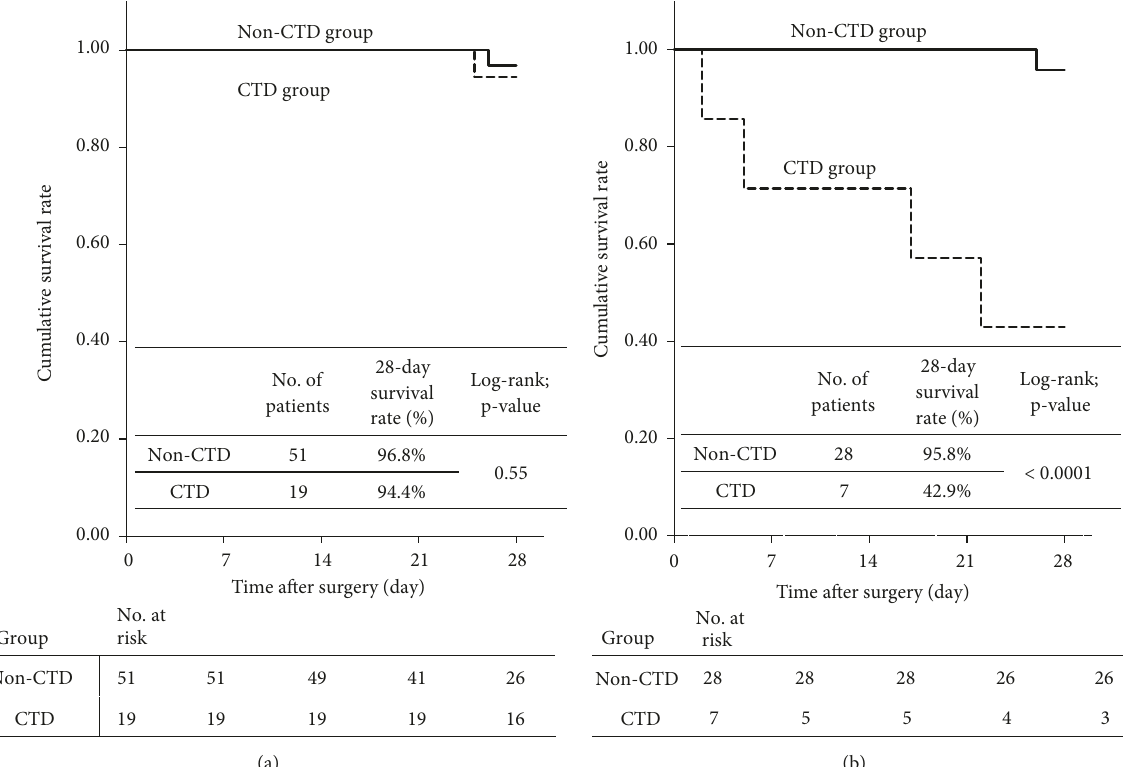
Figure 2: Cumulative survival curves based on the presence of connective tissue disease (CTD) in (a) patients without fecal peritonitis and (b) patients with fecal